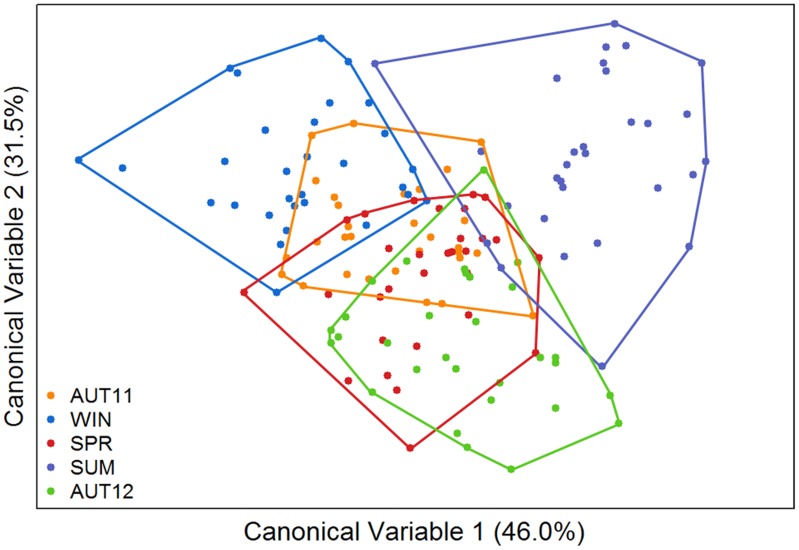
Morphological space of canonical variables (CVs) 1 and 2 yielded by discriminant analysis of wing principal components.Each polygon represents a chronological sample. Relative discriminant power of each variable is between brackets (accounted for 77.5% of the total variation).